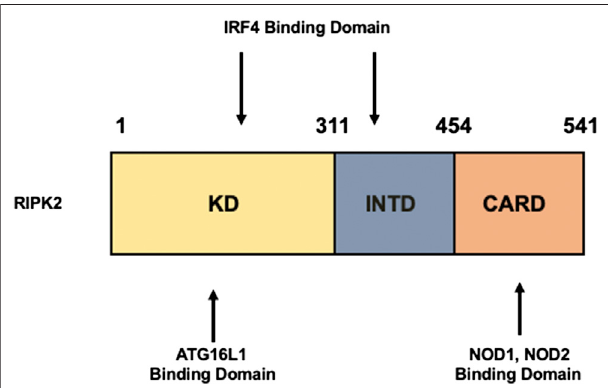
FIGURE 1 | Structure of RIPK2. Receptor-interacting serine/threonine kinase 2 (RIPK2) is composed of a kinase domain (KD), an intermediate domain (INTD), and a caspase activation and recruitment domain (CARD). Interferon regulatory factor 4 (IRF4) binds to the KD and INTD. Autophagy related 16 like 1 (ATG16L1) binds to the KD, whereas nucleotide- binding oligomerization domain 1 (NOD1) and NOD2 interact with RIPK2 via